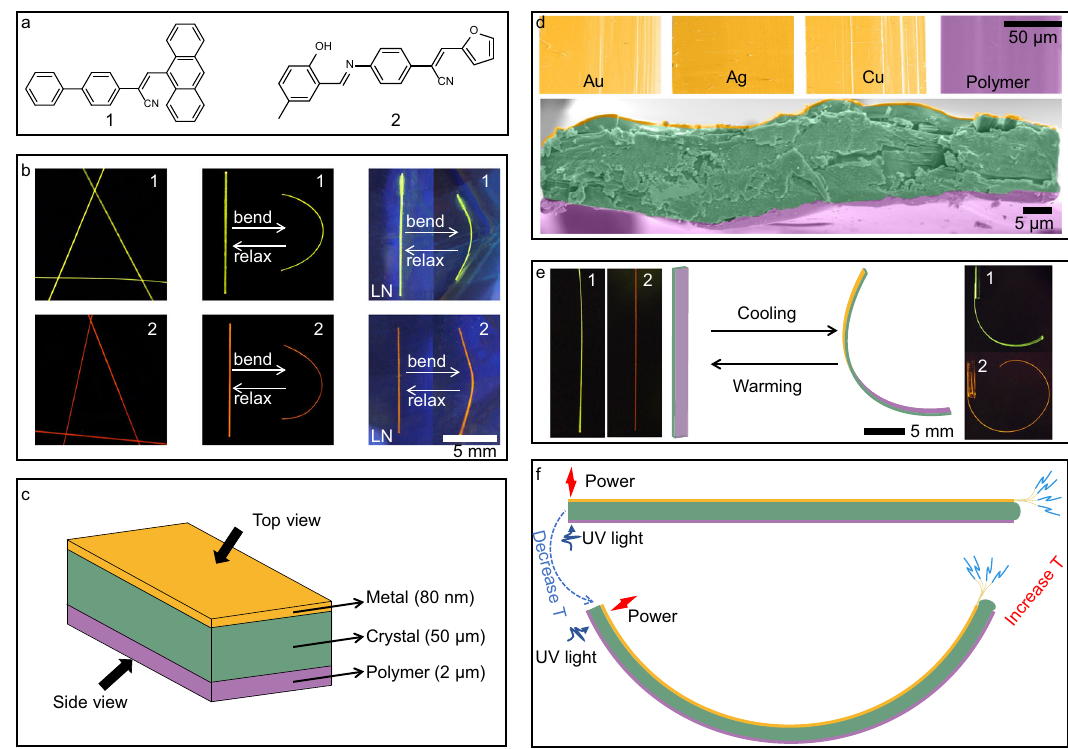
Fig. 1 | Preparation and structure of the hybrid conductive polymer organic crystals. a Chemical structures of the elastic crystals of 1 and 2. b Photographs of crystalsof1and2intheirstraightstate(left)andinthebentstateafterbendingby squeezing at room temperature (middle) and at liquid nitrogen temperature (LN) (right).Forimprovedcontrast,thecrystalswereobservedviatheiremissionunder 365nm light against black background. c A schematic diagram showing the ‘ sandwich ’ M//1,2//P structure. d False-colored Scanning Electron Microscopy